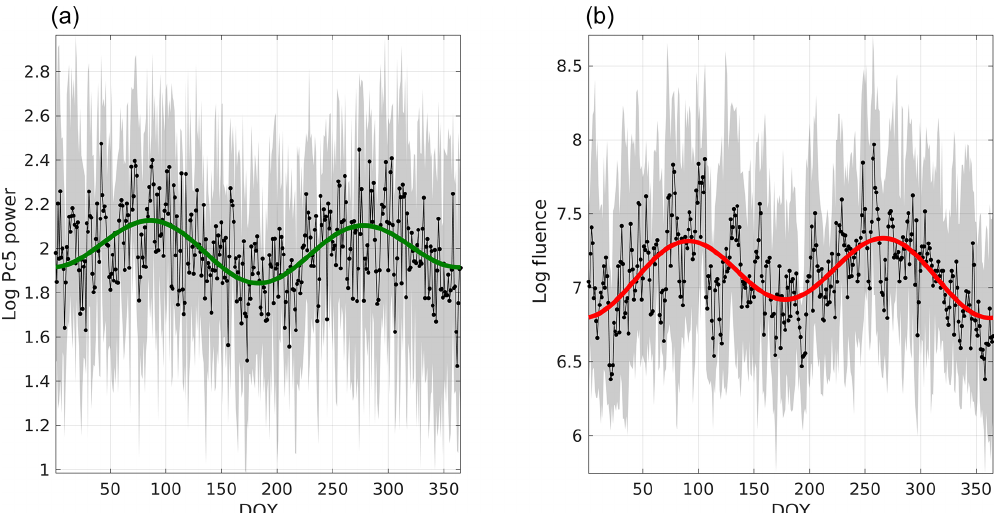
Figure 10. Superposed epoch analysis of the logarithmic daily values of Pc5 power (a) and fluence (b) . The median and quartiles are illustrated as a black curve, lower limit and upper limit of the gray band, respectively. The zero epoch is the first DOY. The green and red curves are fits of the median curve, using f (t) as in Eq. (2). The parameters for the fit on the fluence curve are (A 0 ,A a ,α a ,A sa ,α sa ) = ( 7 . 09 , − 0 . 06 , 1 . 48 , − 0 . 23 , 1 . 72 ) and for the Pc5 power fit (A 0 ,A a ,α a ,A sa ,α sa ) = ( 2 , 0 . 04 , 1 . 28 , − 0 . 12 , 1 . 61 )